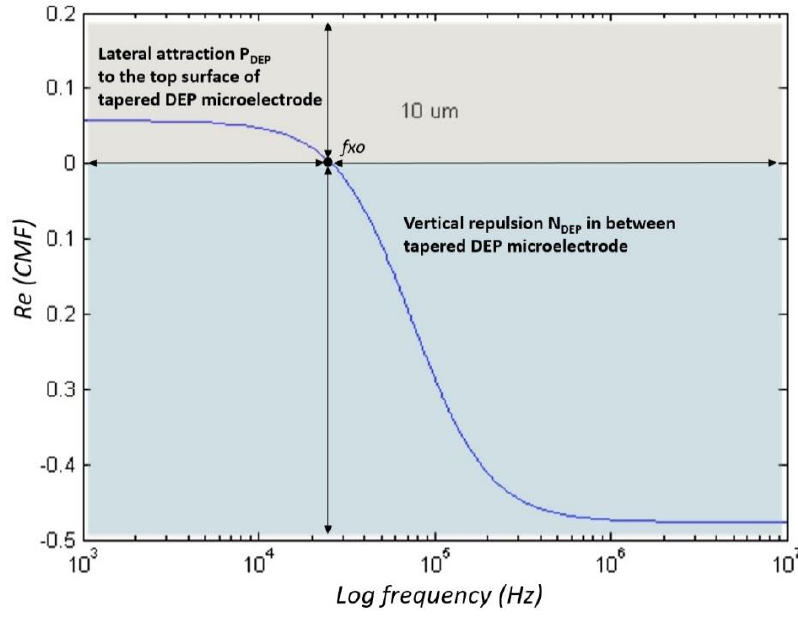
Figure 8. The polarisation factor of CMF for Ps 10 µm.